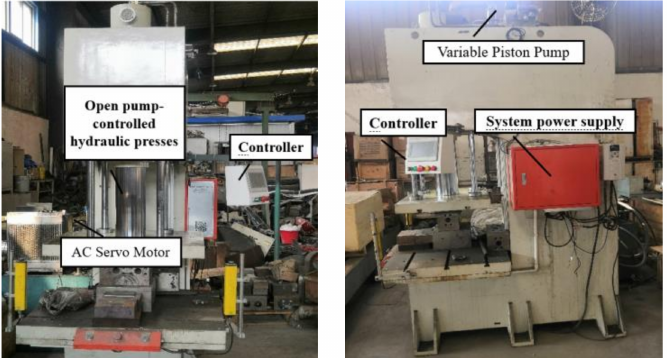
Figure 10. Open pump-controlled hydraulic electromechanical fluid servo position control